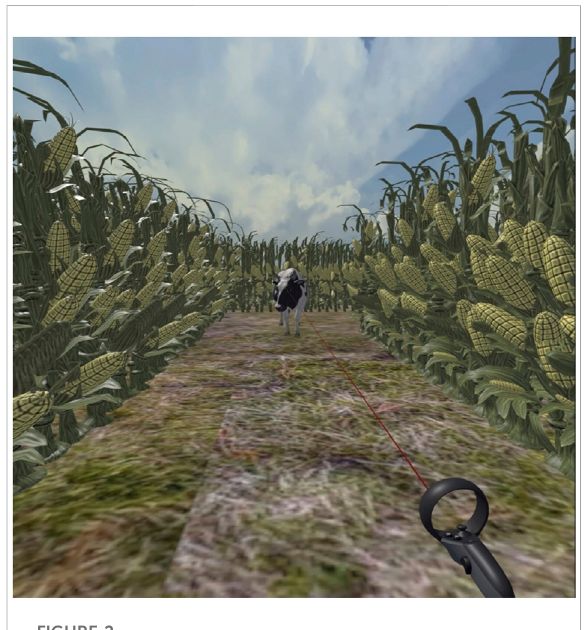
FIGURE 2 Screenshot of Cybersickness Corn Maze showing a cow that might need to be clicked.